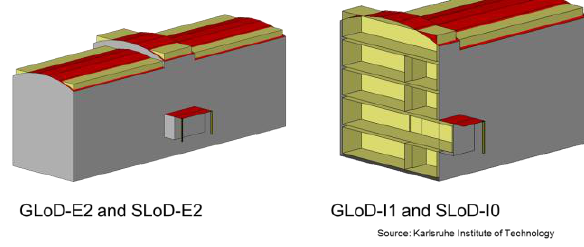
Figure 15: Representation of the exterior shell with generalised geometry, wall and roof surfaces (GLoD-E2/SLoD-